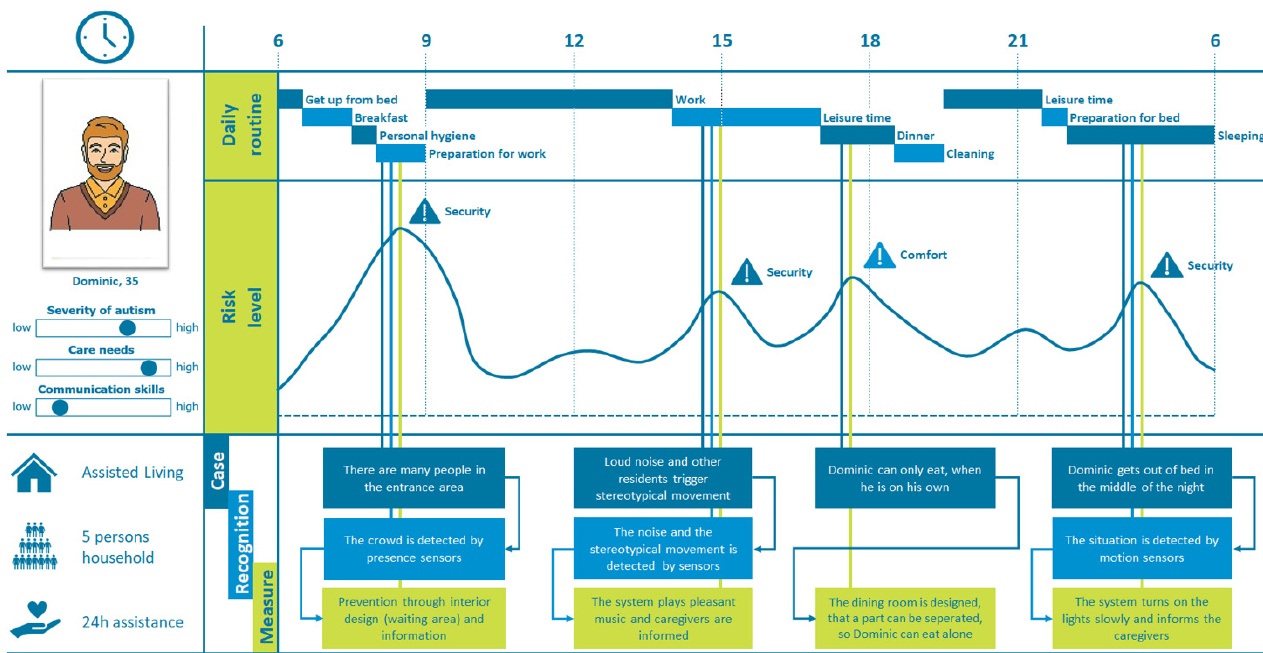
Figure 2. User day of a fictive person on the autism spectrum.